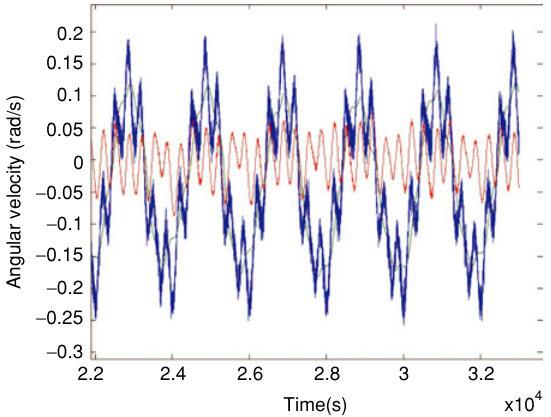
Figure 3 Modelling of tremor as a sinusoid: velocity signals (blue), estimation of voluntary movement (black dotted) and estimation of tremor